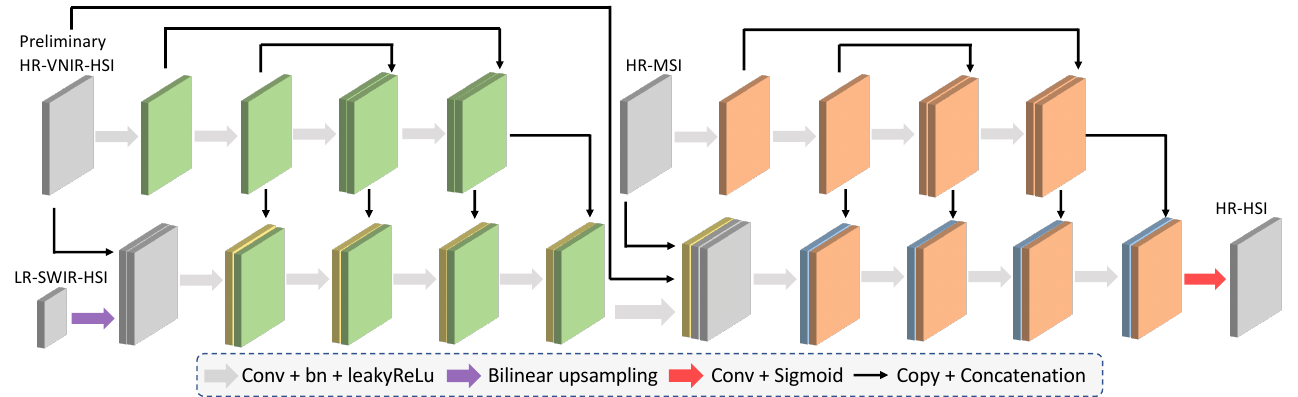
Figure 2. The architecture of the proposed generative